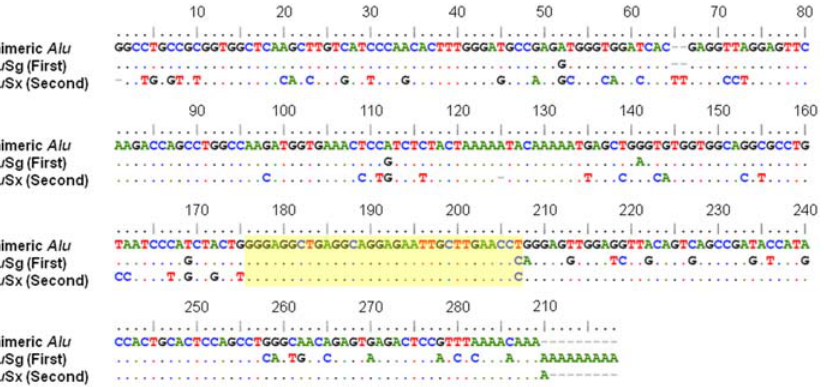
Figure 2. Sequence alignment of one recombined Alu element and two prerecombined Alu elements involved in an Alu -RMI event. The recombined (chimeric) Alu element and two prerecombined Alu elements that contributed to its formation are showed in order. Identical nucleotides shared among elements are indicated by dots. Otherwise, differences are shown with letters. The recombination breakpoint for this event is located in the yellow